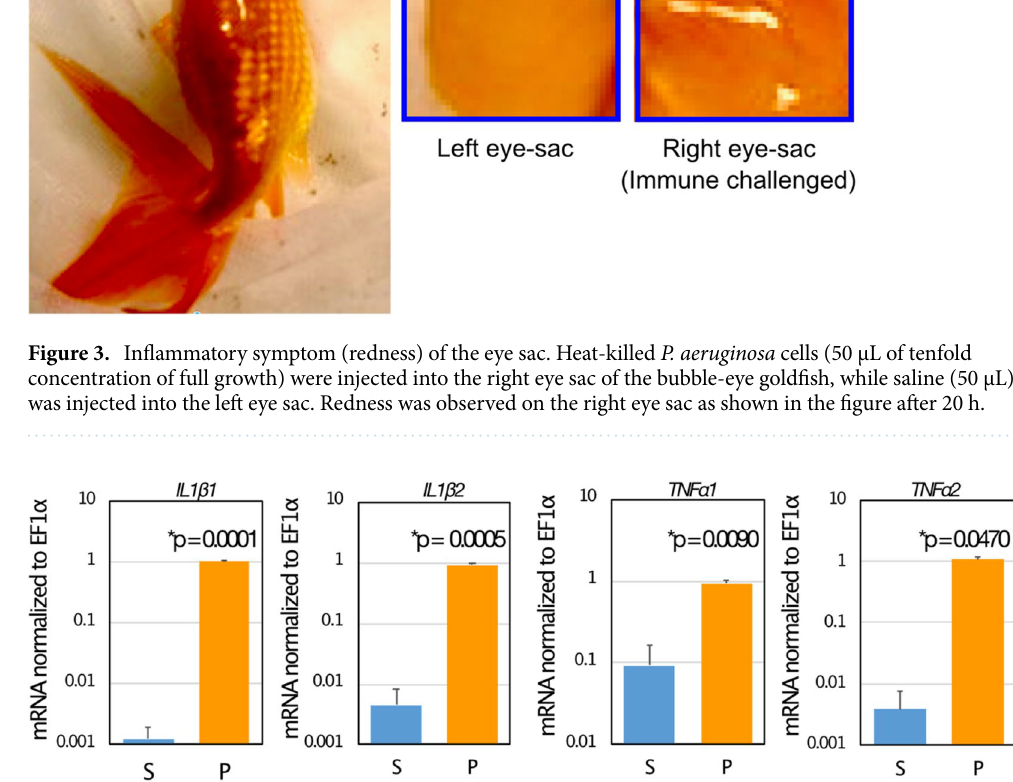
Figure 4. Pro-inflammatory cytokines are expressed in the eye-sac cells in the response to heat-killed P. aeruginosa cells. Twenty-four hours after the injection of heat-killed P. aeruginosa cells (50 µL of tenfold concentration of full growth; P) or saline (50 µL; S) into eye sac, eye sac cells were collected and analyzed for gene expression (see Materials and Methods section for details). Levels of mRNA for IL1β1, IL1β2, TNFα1 and TNFα2 were shown in the figure (values were normalized by a housekeeping gene (EF1α)). A representative result from three replicates is